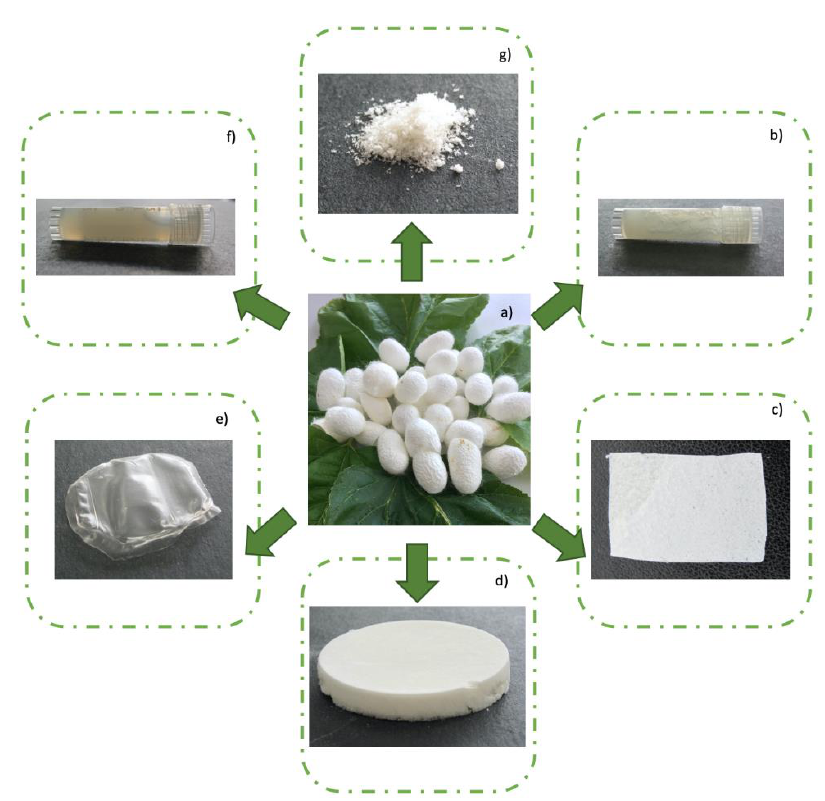
Figure 3. Examples of devices obtained by processing silkworm cocoons ( a ) for wound healing application: fibroin hydrogel ( b ), electrospun fibroin ( c ), sponge ( d ), film ( e ), solution ( f ) and powder ( g ).